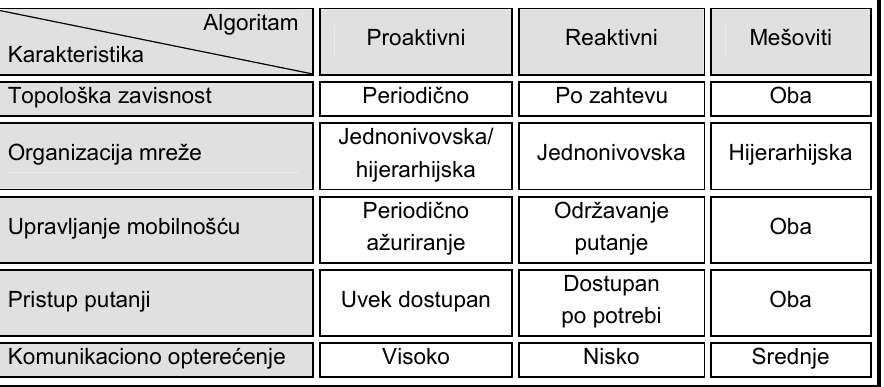
( table-driven ), reaktivni ili protokoli na zahtev ( on-demand ) i hibridni pro- tokoli, č ije su osnovne karakteristike prikazane u tabeli 1. Basic characteristics of proactive, reactive and hybrid routing protocols